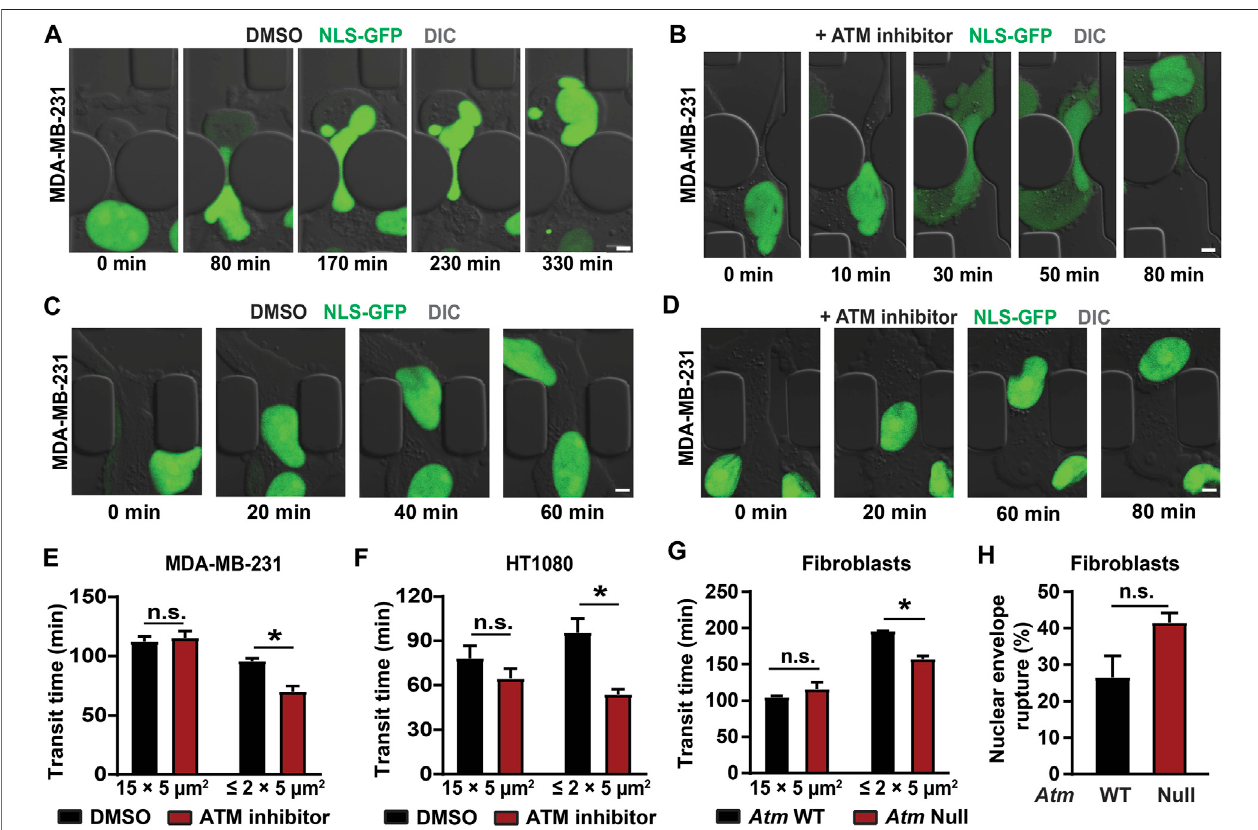
FIGURE 5 | Cells lacking ATM migrate faster through con fi ned spaces. (A) Representative time-lapse image sequences of an MDA-MB-231 breast cancer cell expressing NLS-GFP and treated with vehicle control (DMSO) during migration through a 1 × 5 μ m 2 constriction in the micro fl uidic device. Scale bar: 5 µm. (B) RepresentativeimagesequenceofanMDA-MB-231breastcancercellexpressingNLS-GFPandtreatedwithanATMinhibitor (KU-55933)duringmigrationthrougha1 ×5 μ m 2 constrictioninthemicro fl uidicdevice.Scalebar:5 µm. (C) Representativetime-lapseimagesequencesofanMDA-MB-231breastcancercellexpressing NLS-GFP and treated with vehicle control (DMSO) during migration through a 15× 5 μ m 2 control channel in the micro fl uidic device. Scale bar: 5 µm. (D) Representative image sequence of an MDA-MB-231 breast cancer cell expressing NLS-GFP and treated with an ATM inhibitor (KU-55933) during migration through a 15 × 5 μ m 2 control channel in the micro fl uidic device. Scale bar: 5 µm. (E) Quanti fi cation of transit times for MDA-MB-231 cells to migrate through ≤ 2 × 5 μ m 2 constrictions or 15 × 5 μ m 2 control channels when treated with ATM inhibitor KU-55933 or vehicle control (DMSO). *, p < 0.05 based on two-way ANOVA with Tukey ’ s multiple comparison test; N =3foreachgroup,representingthemeansofthreeindependentexperiments;totalnumberofcellsanalyzed:114cellsforDMSOand83cellsforATMinhibitorfor thesmallconstrictions;72cellsforDMSOand 38cellsforATMinhibitor forthelargercontrolchannels. (F) TransittimesforHT1080 fi brosarcomacellstocrossthe ≤ 2× 5 μ m 2 constrictions or 15 × 5 μ m 2 control channels when treated with ATM inhibitor KU-55933 or vehicle control (DMSO). *, p < 0.05 based on Two-way ANOVA with Tukey ’ s multiple comparison test; N = 3 for each group, representing the means of three independent experiments; total number of cells analyzed: 200 cells for DMSO and276cellsforATMinhibitorforthesmallconstrictions;182cellsforDMSOand140cellsforATMinhibitorforthelargercontrolchannels. (G) Transittimesfor Atm wild- type (WT) or Atm -Null MEFs to cross the ≤ 2 × 5 μ m 2 constrictions or the 15 × 5 μ m 2 control channels. *, p < 0.05 based on Two-way ANOVA with Tukey ’ s multiple comparison test; N = 3 for each group, representing the means of three independent experiments; total number of cells analyzed: 336 Atm WT and 221 Atm -Null MEFs forthesmallconstrictions;133 Atm WTand111 Atm -NullMEFsforthelargercontrolchannels. (H) Quanti fi cationofnuclearenveloperuptureeventsofAtmWTandAtm- NullMEFsmigratingthroughthe ≤ 2×5 μ m 2 constrictions.Thedifferencewasnotstaticallysigni fi cant( p =0.11,basedonthemeansofthreeindependentexperiments. N = 3. Error bars in this fi gure represent mean ± s. e.m. of the mean values of each experiment.